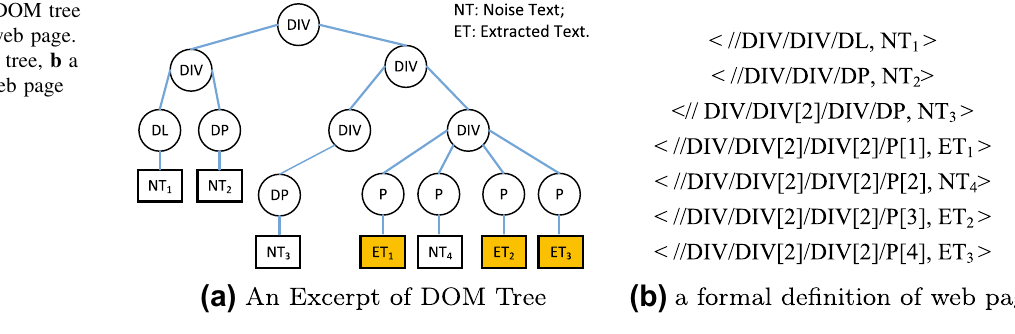
Fig. 1 An excerpt of DOM